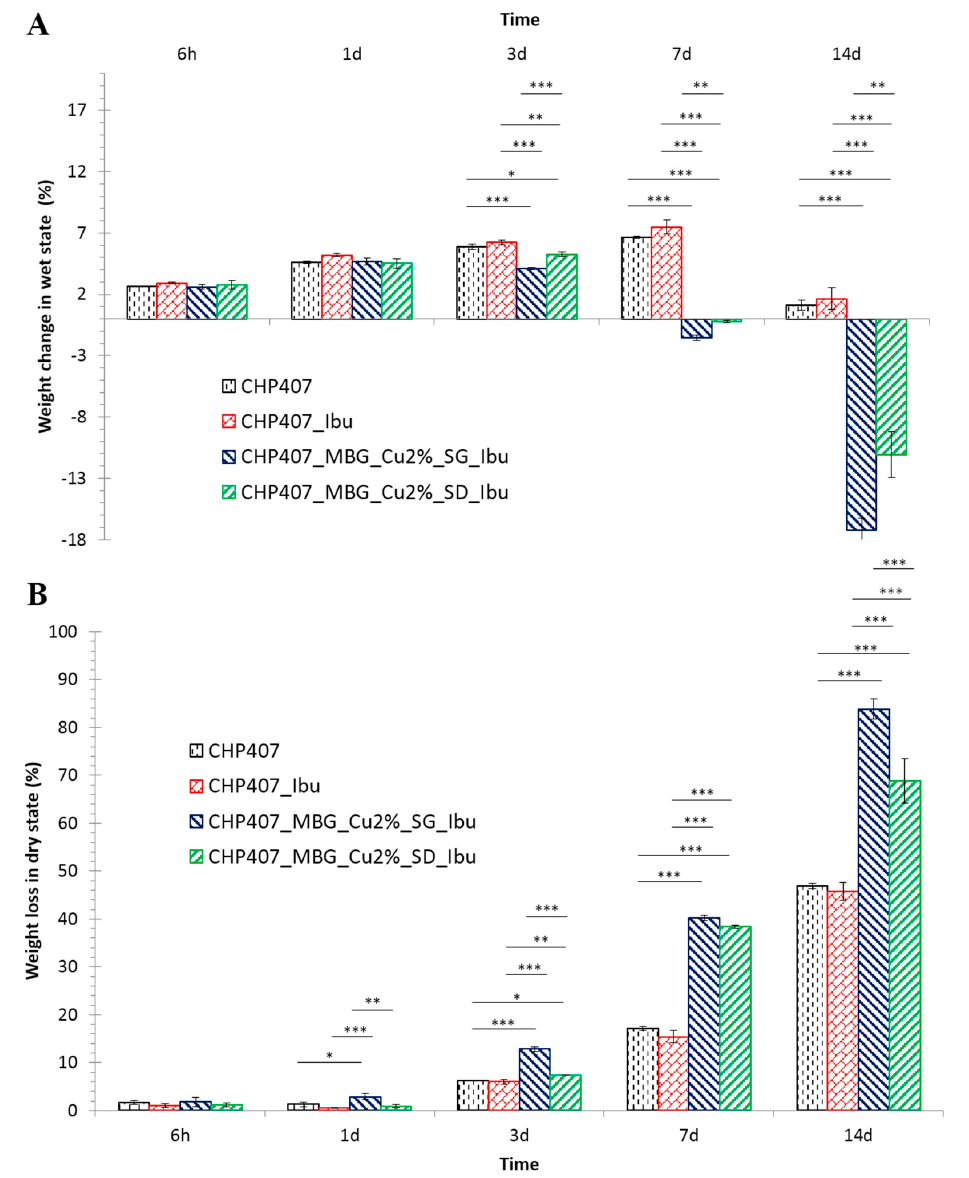
Figure 5. Swelling ( A ) and weight loss ( B ) of CHP407, CHP407_Ibu, CHP407_MBG_Cu2%_SG_Ibu and CHP407_MBG_Cu2%_SD_Ibu gels evaluated at 6 h, 1d, 3d, 7d and